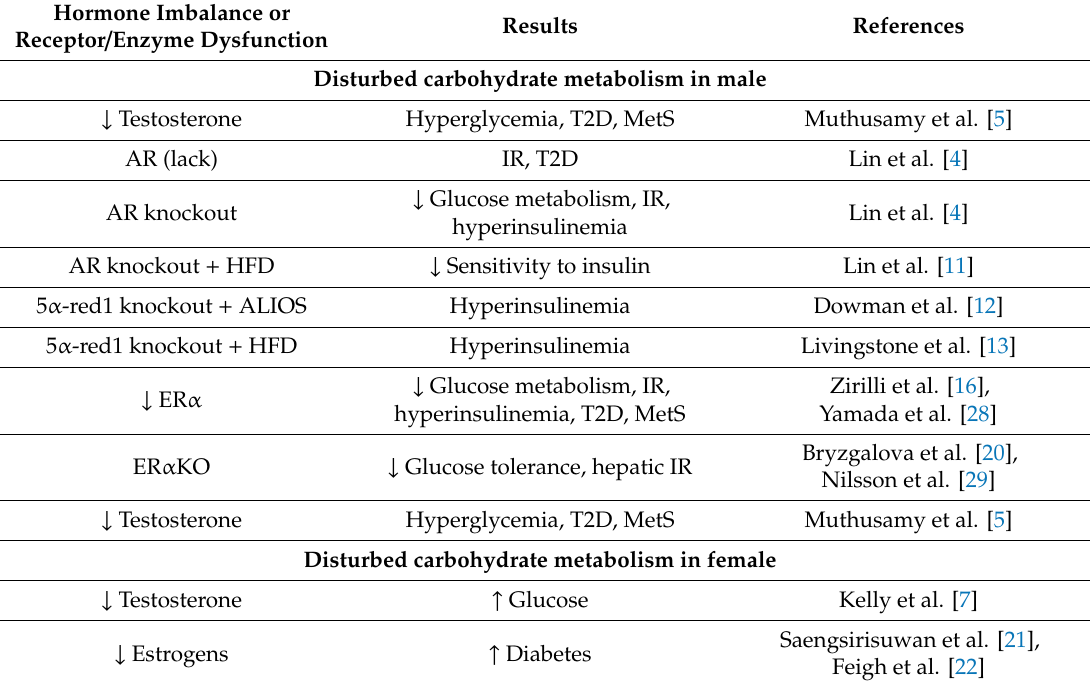
Table 1. Summary data on impact of the hormone imbalance, disturbance of the sex hormone receptors and the enzyme activity / expression on the hepatic metabolism of carbohydrate in relation to the gender as a cause of many physiological dysfunctions, syndromes or